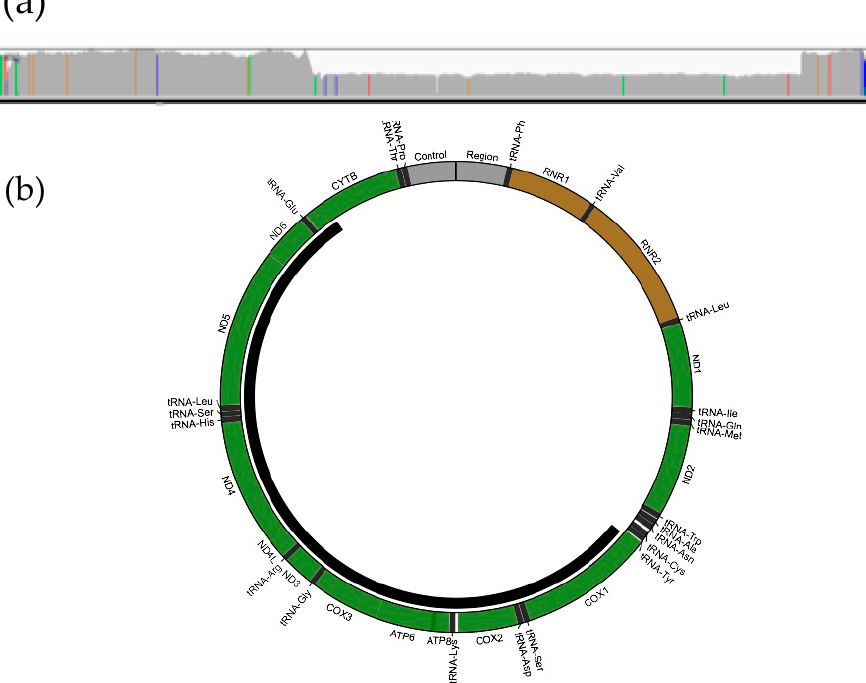
Figure 4. Deletion in the mtDNA in P3 identified by GS. ( a ) IGV coverage plot shows ≈ 50% fewer reads in the area spanning 9031bp of the mtDNA; ( b ) MitoBreak figure depicts the single large-scale heteroplasmic deletion spanning 23 mitochondrial genes (black bar).